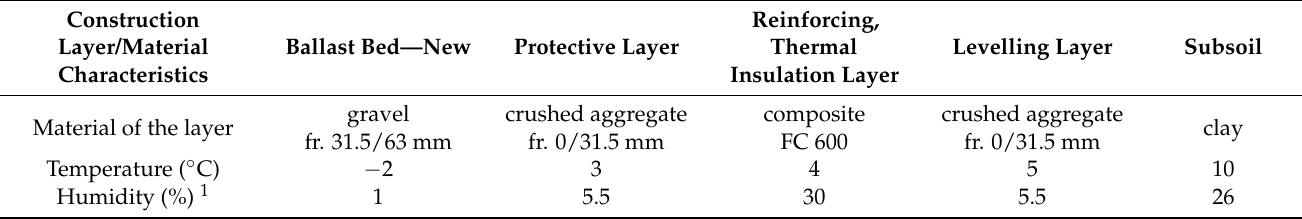
Table 4. Input parameters of numerical modelling—results of